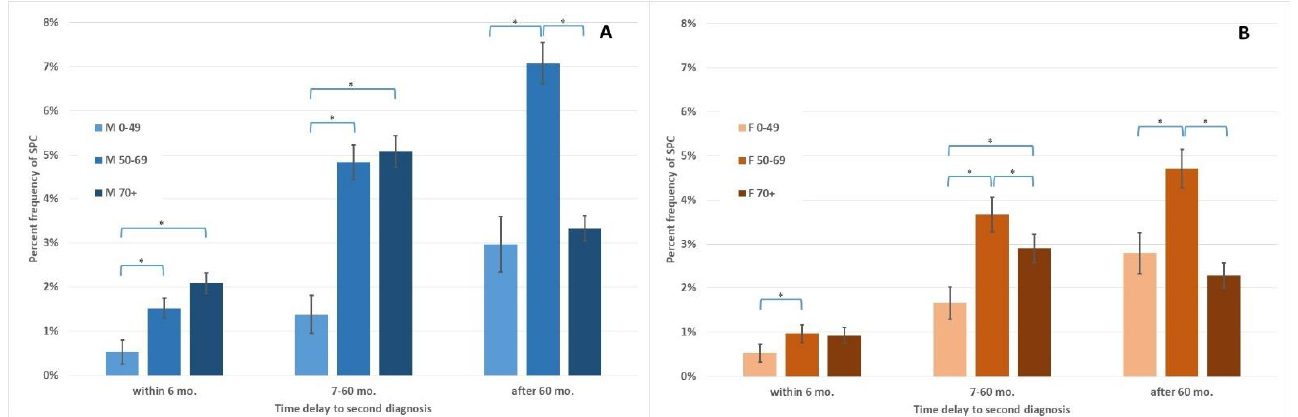
Figure 4. Percentage incidence of a second primary cancer in patients, 2003–2007. Panel A : M, males; Panel B : F, females. Age ranges at the diagnosis of an FPC: 0–49 years old; 50–69 years old; 70+ = age 70 and above. Second diagnosis was within a time frame of 6 months (synchronous), between 7 and 60 months, or after 60 months (five years) during follow-up. Note: * significantly different, p < 0.05, chi-squared tests; error bars: 95% confidence intervals.